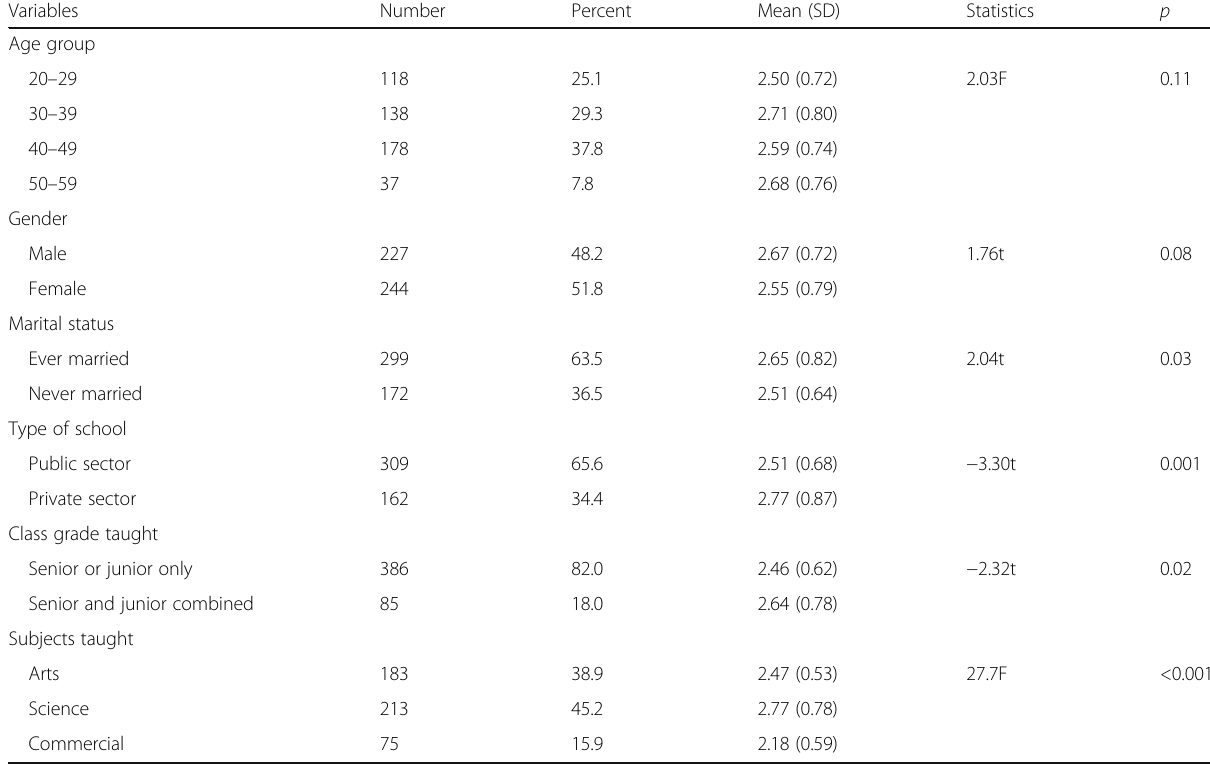
Table 2 Sociodemographic characteristics of participants